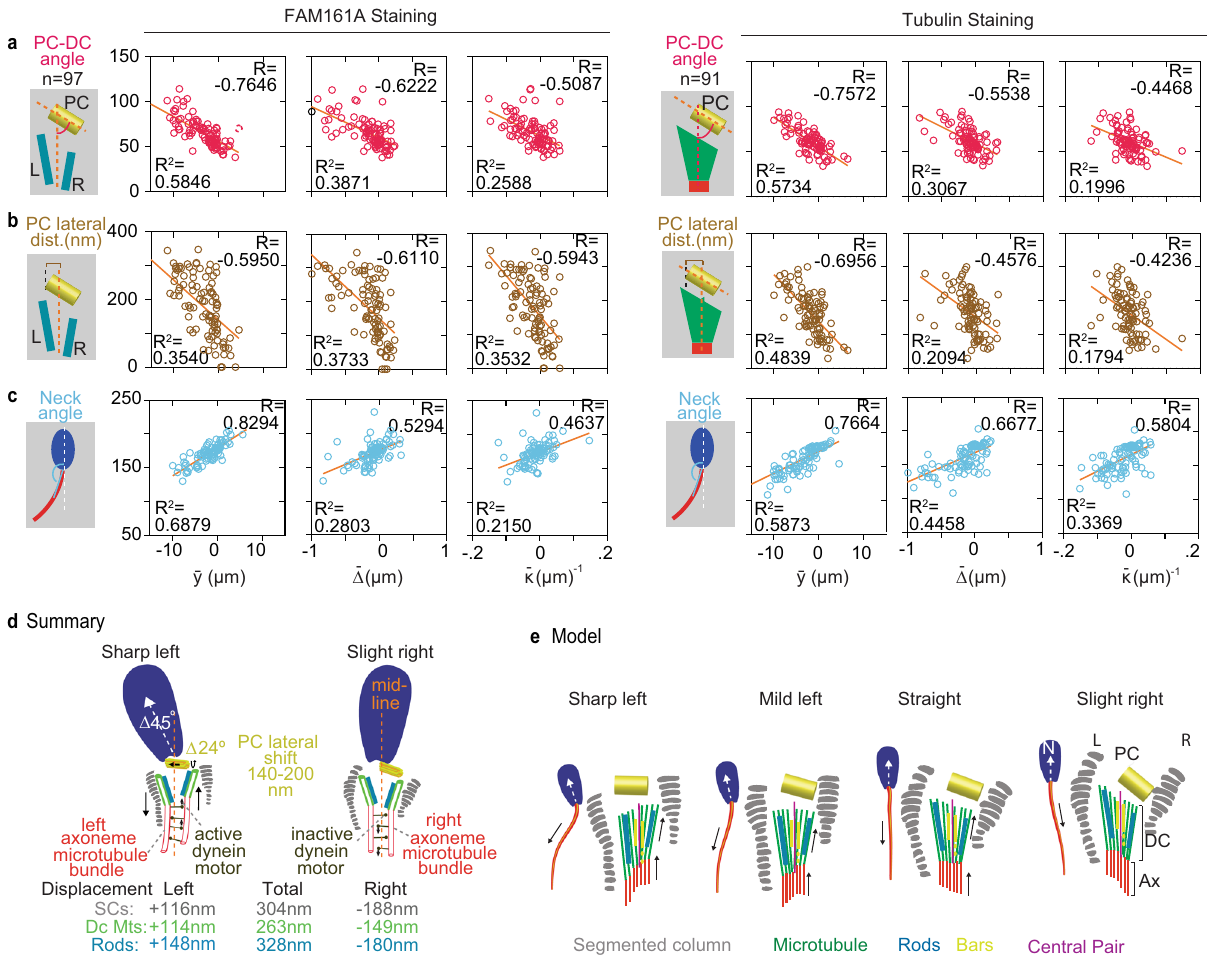
Fig. 5 Sperm tail beating correlates with PC and head position. a – c Correlation analysis between tail variables, beating amplitude ( (cid:1) y ), inter fi lament sliding ( (cid:1) Δ ), curvature ( (cid:1) κ ), and PC – DC angle ( a ), PC lateral shift ( b ), and head – neck angle ( c ) with FAM161A (left panels) and tubulin (right panels) staining. The schematics shown to the left of each graph represent the measurements plotted on the y -axis. All the tail variables are plotted on the x -axis. R Pearson correlation, R 2 linear regression. Each circle represents the data point for an individual cell. All experiments were repeated three times independently with similar results. All Correlation analyses in a – c are signi fi cant ( P < 0.0001). d The summary of overall magnitude in deformation of DC, PC, SCs, and head kinking between sharp left beating cells to slight right beating cells. e Model showing deformation of DC, PC, SCs, and head kinking during sperm tail beating from sharp left to slight right. Source data are provided as Source Data